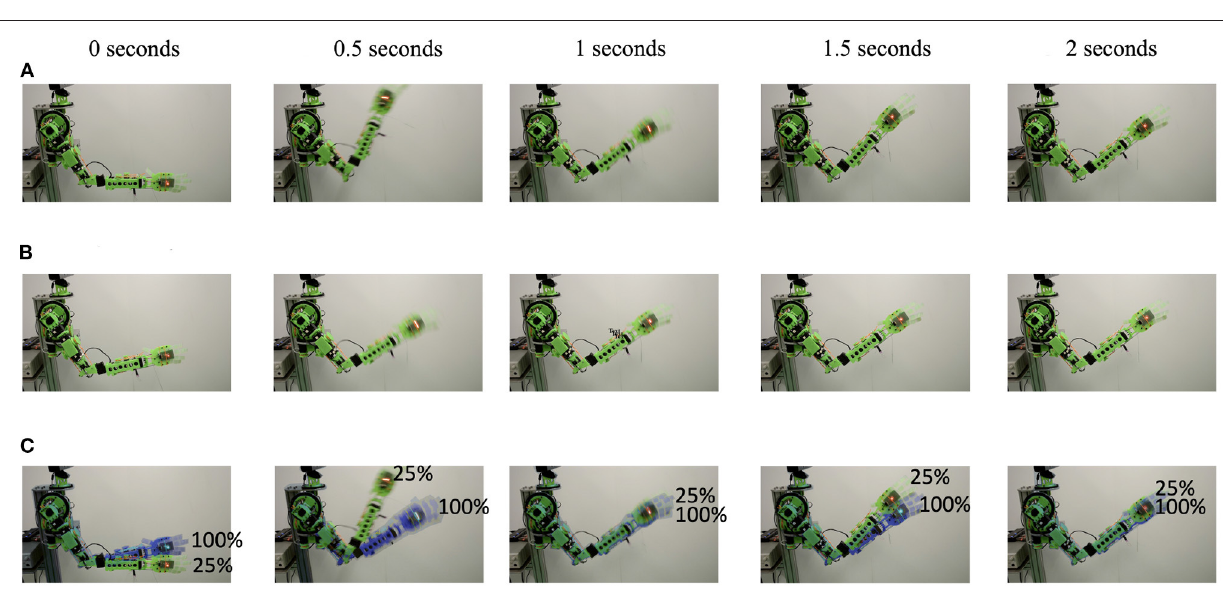
FIGURE 7 | (A) Elastic energy is stored, but the robot arm response is quickly damped, even with low levels of actuator co-contraction. Thus the risk of damage and injury from such a release is reduced. Image series of a 1 kg mass release for 25% co-contraction. (B) Co-contraction can be used to limit the robot arm response to an elastic release. That is, the antagonist tendon can be kept taut, but not loaded, to react passively to the release of a force loading the agonist tendon. Image series of passive response to 1 kg mass release for 100% co-contraction. (C) Shows the overlapping image series from (A,B)